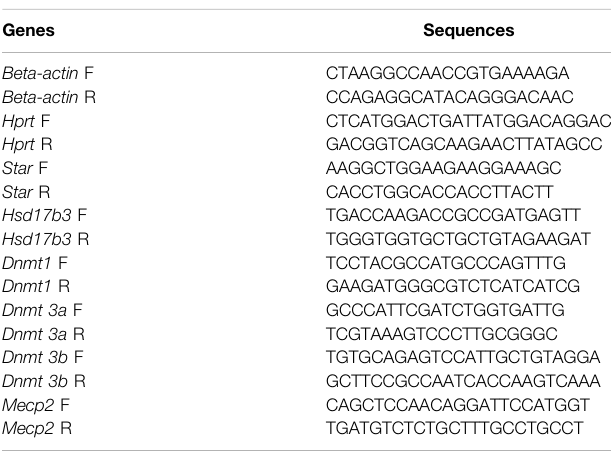
TABLE 1 | Primer sequences used in the